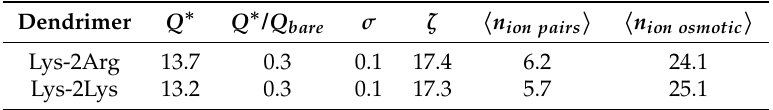
Table 4. The local characteristics of Lys-2Arg and Lys-2Lys dendrimers: the average number of ion pairs (cid:104) n (cid:105) between the counterions and the charged groups in the dendrimer, the effective dendrimer ion pairs charge Q ∗ (e), the degree of a charge renormalization of the dendrimer Q ∗ / Q bare , the surface charge density σ (e/nm 2 ), and ζ potential (mV) at temperature T = 310 K.